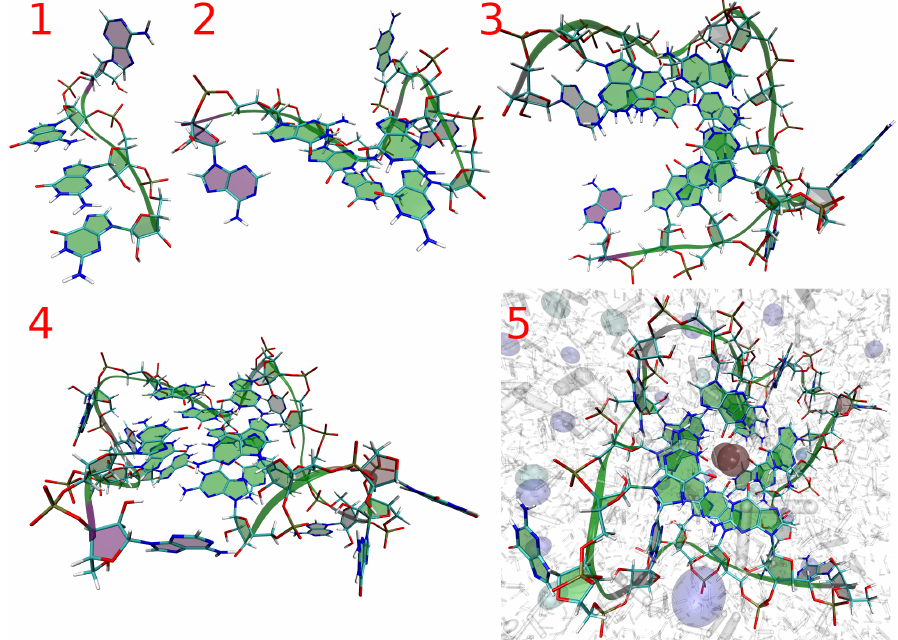
Figure A7. Stages of the folding simulation of an example G-quadruplex with the sequence A-GGG- AG-GGG-C-GGG-AGU-GGG-C, performed by means of the NAB-GQ-builder. ( 1 ) The first G-strand is ready. ( 2 ) One guanine is still missing in the second G-strand. ( 3 ) The third G-strand is ready. ( 4 ) Only one guanine is missing from the core. ( 5 ) The complete, slightly minimized quadruplex with manually added K + ions (dark-pink spheres), in explicit water and